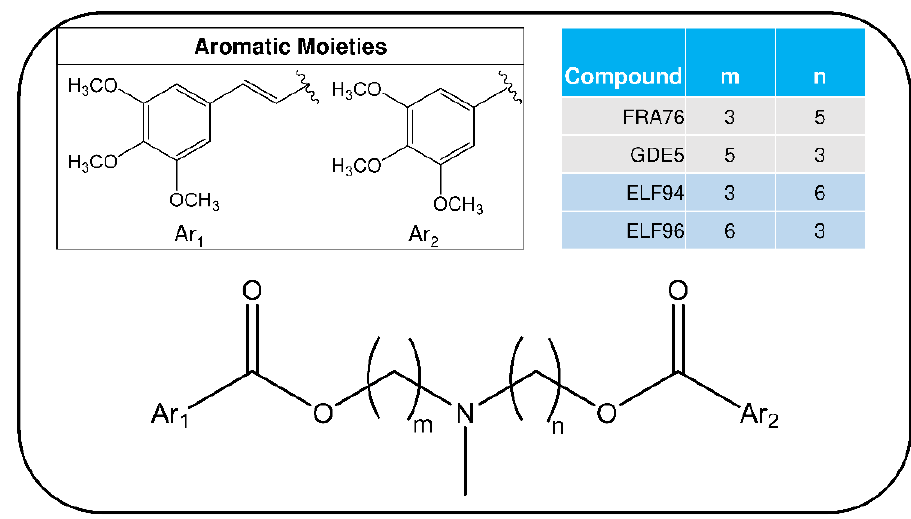
Figure 1. Chemical structures of P-gp inhibitors selected for this study. 95